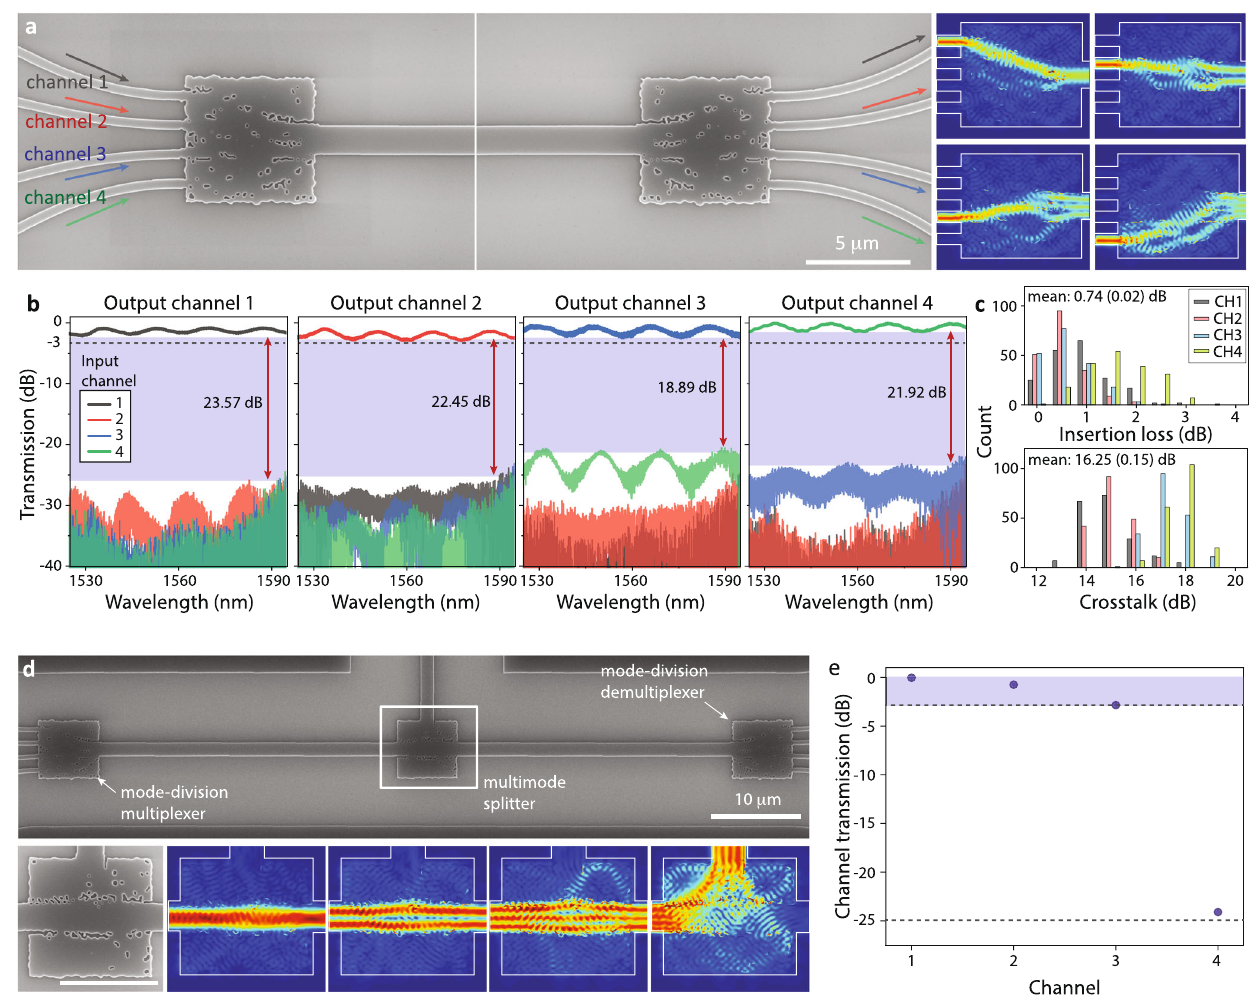
Fig. 2 | Inverse design of silicon multimode photonics. a – c Broadband, low- crosstalk MDM multiplexers: a SEM images of back-to-back MDM multiplexer devices with simulated mode conversion (right). b Measured transmission of the back-to-back MDM multiplexer structure. This broadband structure is utilized in the WDM-MDM data transmission experiments (see Fig. 3). c Insertion loss and crosstalk histograms of the back-to-back MDM multiplexers fabricated in a semi- conductor foundry 41 . d , e Multimode splitter which combines a waveguide bend